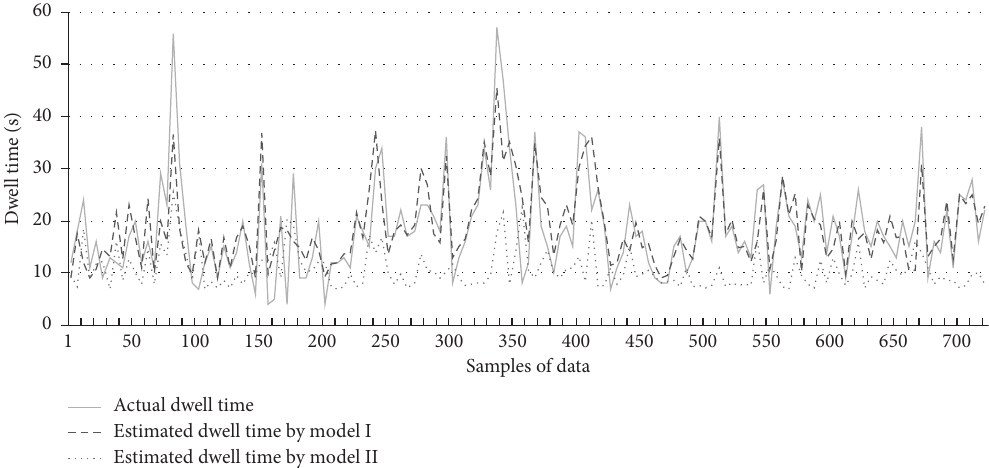
Figure 4: Comparison between real and estimated dwell times based on model I and model